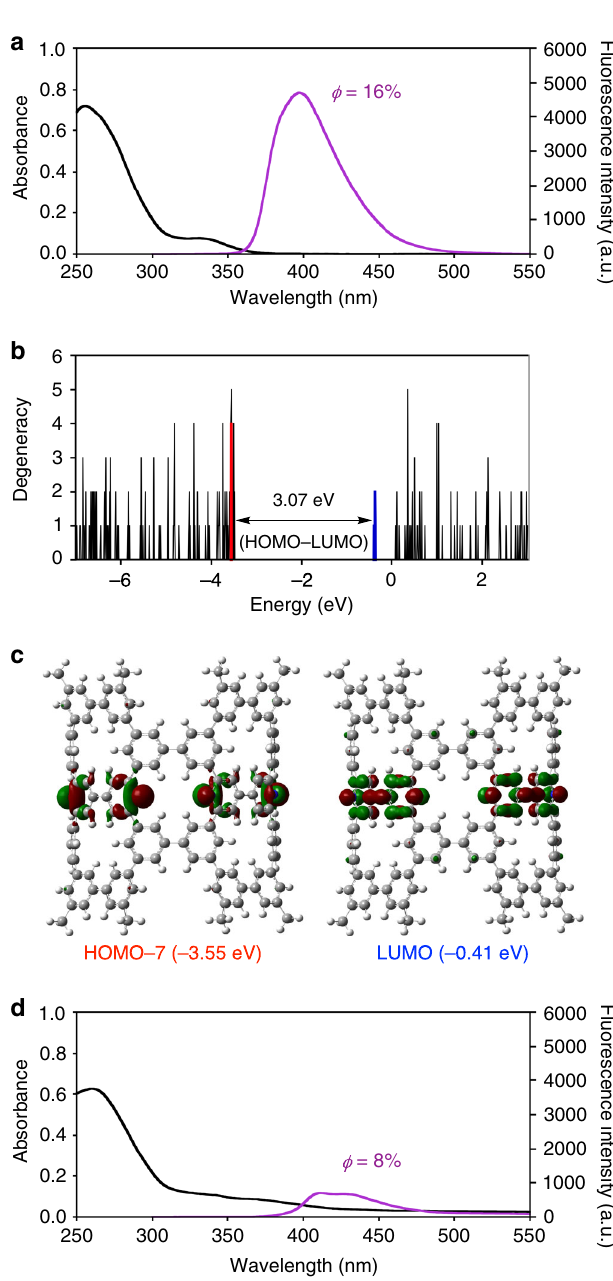
Fig. 4 Representative properties of (12,12)-NpNT. a Absorption and fl uorescence spectra of (12,12)-NpNT (1.2 × 10 − 6 M in CH b Histogram sorting 213 orbitals of (12,12)-NpNT by energy on the basis of the DFT calculations. Orbitals originating from pyridine units are coloured in red (occupied) and blue (unoccupied). See Supplementary Fig. 9 for details. c Representative Kohn – Sham orbitals. d Absorption and fl uorescence spectra of (12,12)-NpNT (1.2 × 10 − 6 M in CH the presence of tri fl uoroacetic acid (7.4 × 10 − 3